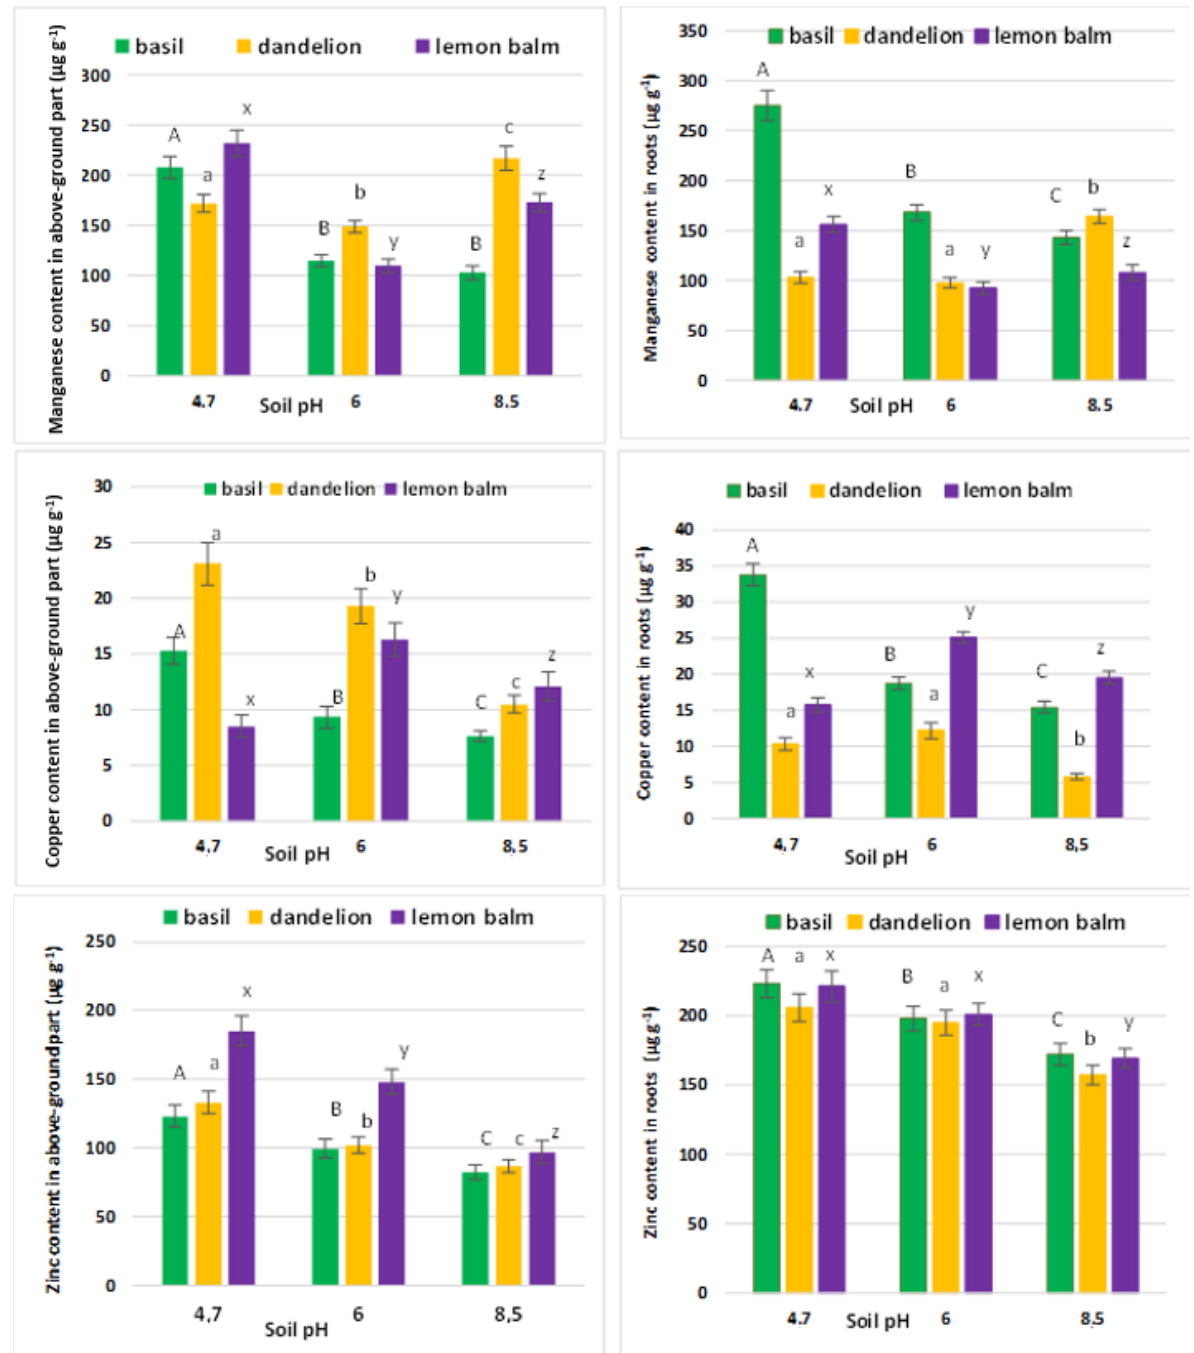
Figure 2. Manganese, copper and contents in above-ground parts and roots of basil, dandelion and lemon balm plants displayed against the pH modifications. Specific letters illustrate the statistically significant differences as computed with the Tukey’s HSD test ( p = 0.95); roots and above-ground parts are treated independently.